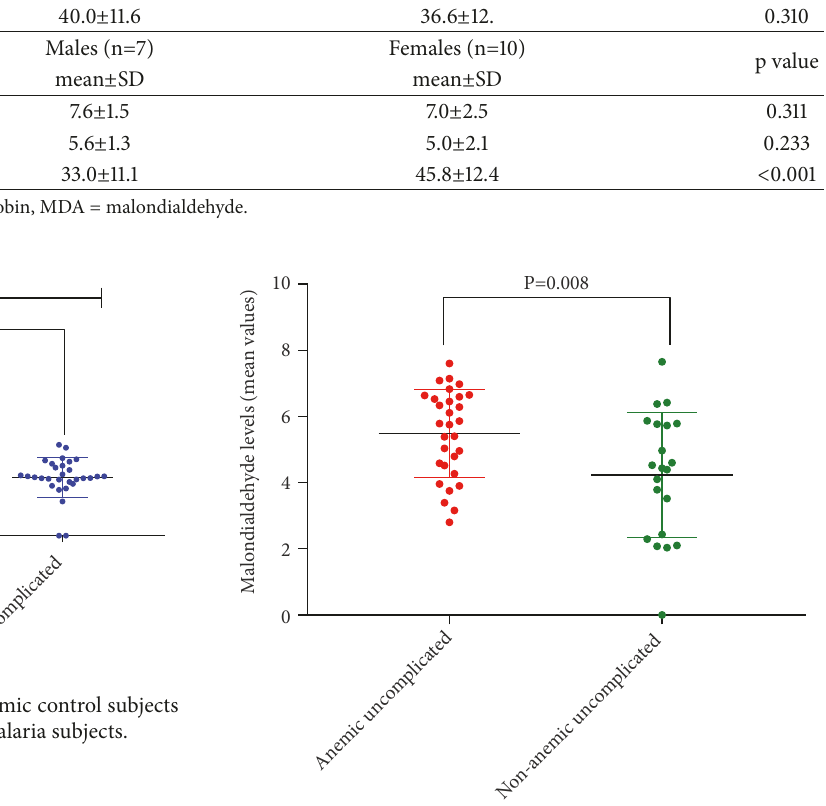
Figure 3: Comparison of malondialdehyde levels between anemic and nonanemic subjects with uncomplicated